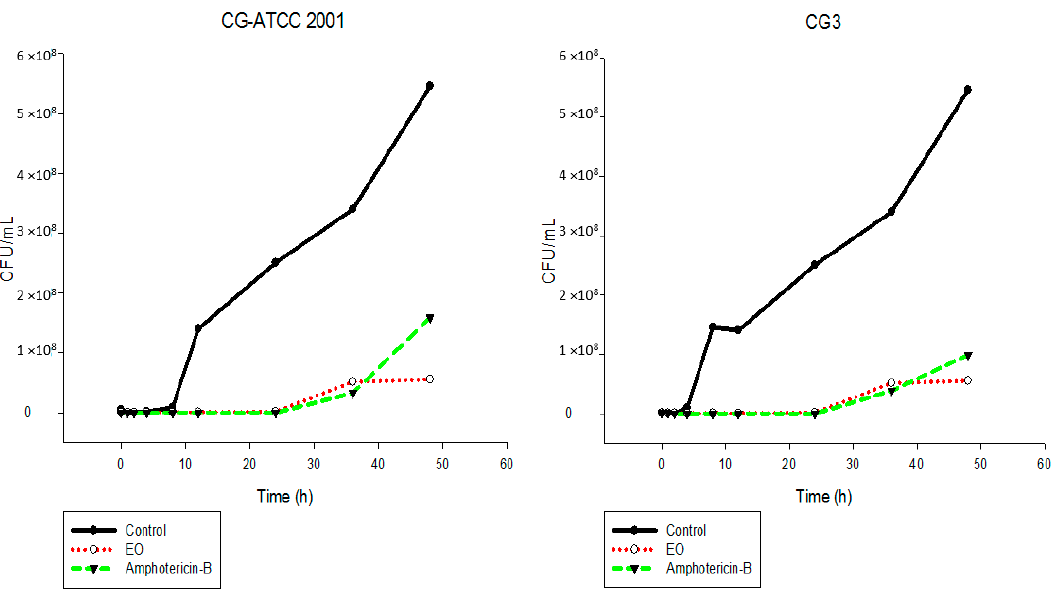
Figure 4. Time-kill curves of C. glabrata ATCC 2001 and CG3 following exposure to the essential oil of C. nardus and amphotericin-B. Control represents the untreated Candida cells.